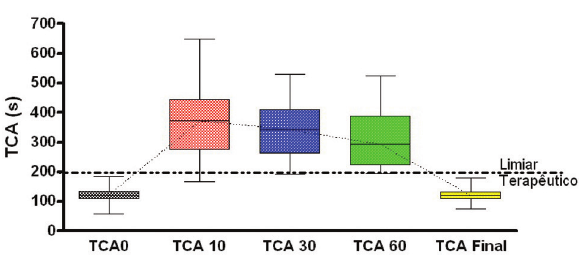
Fig. 7 - Evolução dos valores de TCA (Tempo de Coagulação Ativada) ao longo do procedimento de RM sem